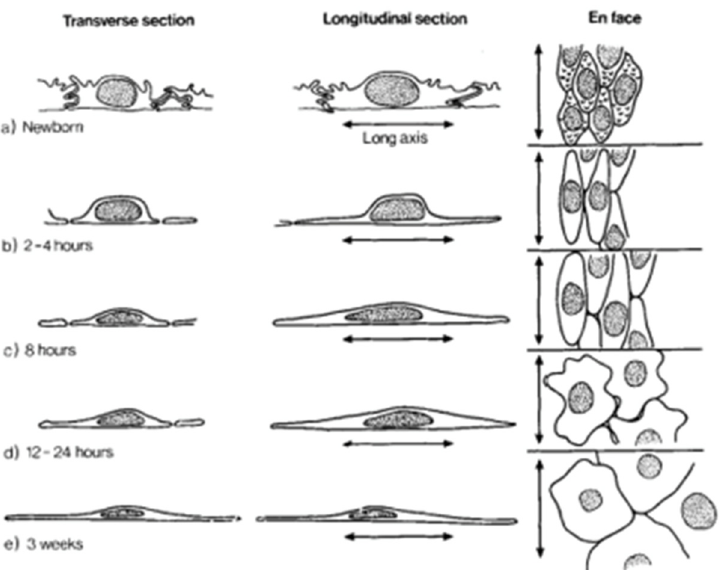
Figure 4. This diagram illustrates shape changes in the endothelial cells of intra-acinar arteries during the first 3 weeks of life (porcine). The endothelial cells of the intra-acinar arteries showed marked changes in cell shape and relationships after birth, while those of large preacinar arteries did not. The first structural changes detected during the first 30 min of life occurred in the endothelial cells lining the intra-acinar arteries. Adapted from Hall and Haworth [31] (with